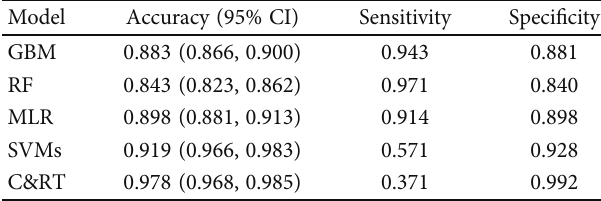
Table 4: Performance of validation of the DR prediction models.